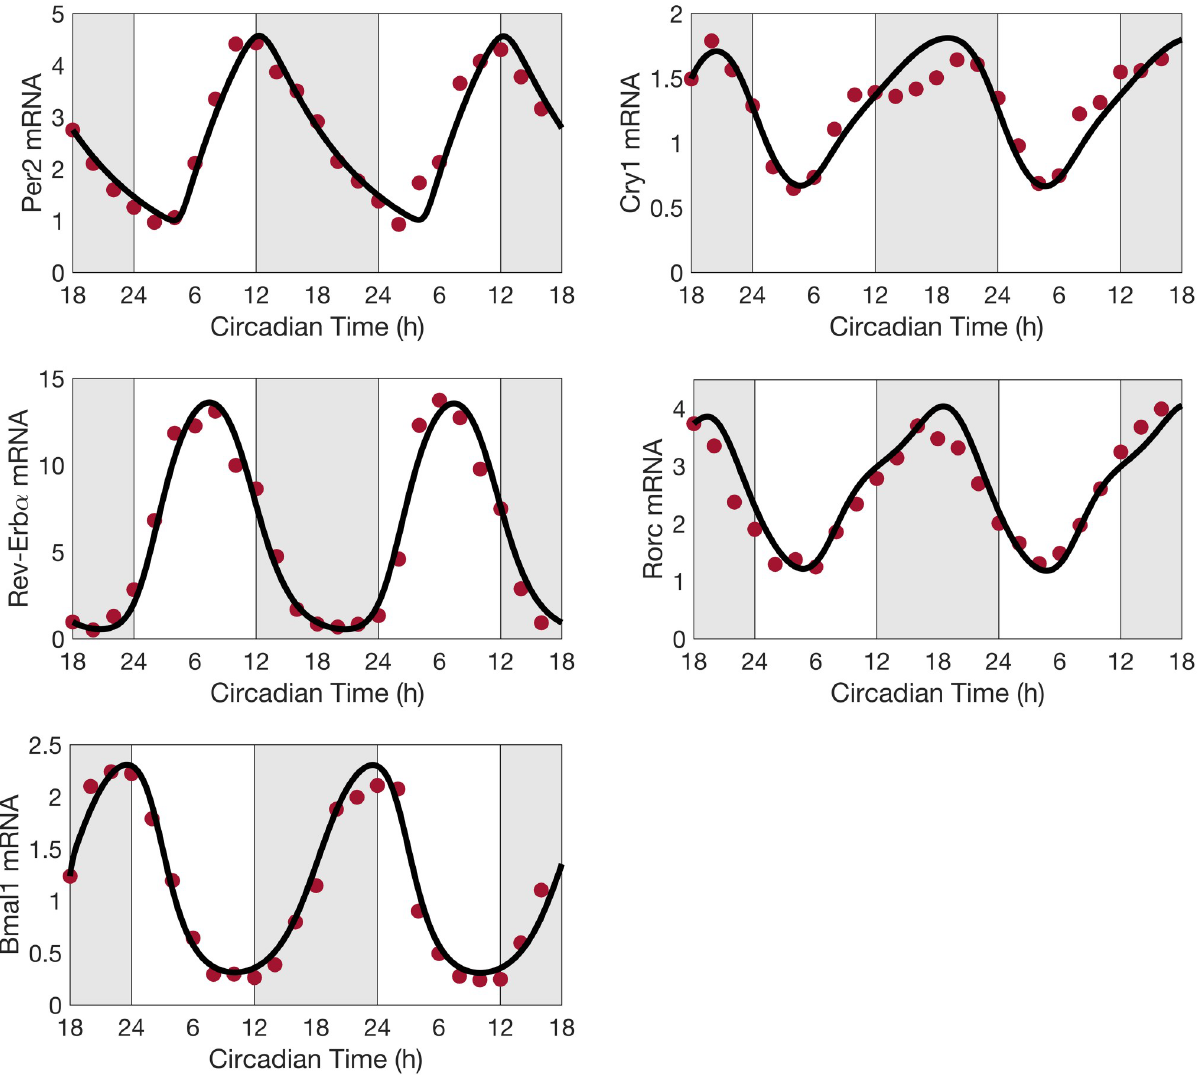
Fig 3. Predicted clock gene time profiles. Comparison of predicted time profiles (solid lines) for Per , Cry , Rev-Erb , Ror and Bmal1 , with experimental data (circles) for Per2 , Cry1 , Rev-Erb α , Rorc , and Bmal1 mRNA expression levels obtained in mouse lungs in constant darkness. Gray shading and white regions correspond to activity and restcycles,